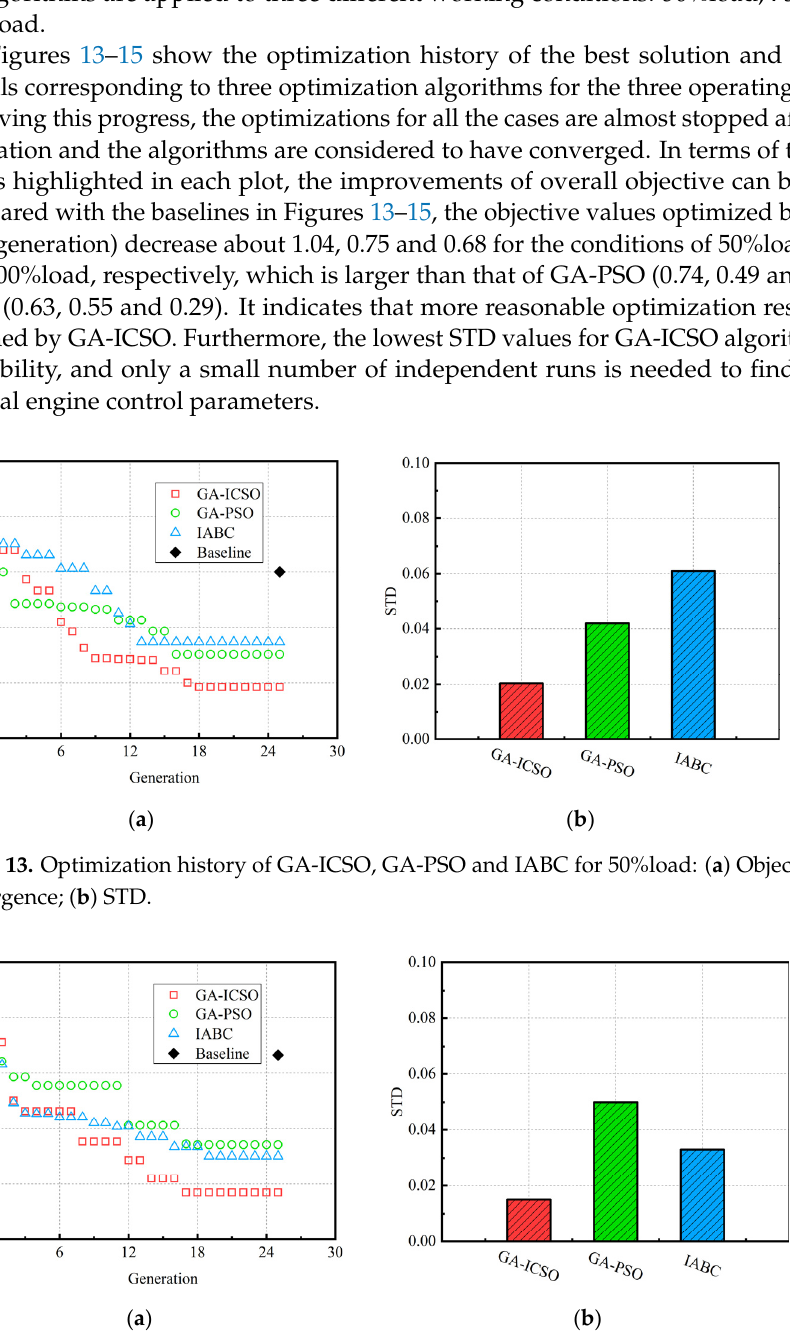
( b ) Figure 15. Optimization history of GA-ICSO, GA-PSO and IABC for 100% load: ( a ) Objective func- tion convergence; ( b ) STD. In addition, considering the effects of tuning parameters on optimization results, the values of crossover rate, mutation rate and G in GA-ICSO were adjusted for comparative optimization analysis. However, it is found that the obtained optimal solutions are almost unchanged, indicating that the tuning parameters have less of an influence on the optimi- zation results of GA-ICSO. That can be explained by the engine control parameters in baseline conditions having already been roughly optimized by traditional Design of Ex- periment (DOE) methods, which are used as initial values during GA-ICSO optimization. This can also help to narrow down the optimization range. Therefore, the effects of tuning parameters on optimization process have been weakened. Subsequently, the inspection of CN, NOx and BSFC is carried out to check the solu- tion success. In order to analyze the optimization results of CN, BSFC and NOx visually, the concept of optimization percentage is defined and expressed as the following: Optimal Baseline Optimization percentage